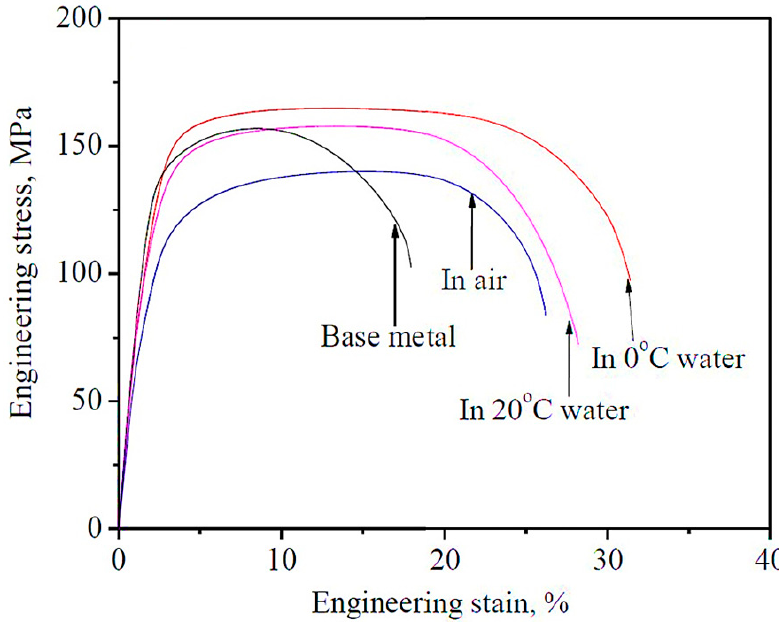
Figure 22. Engineering stress-strain curves of the base metal and weld joints along the longitudinal direction of the hot bands of AA 3003 Al alloy welded in air, 20 °C water, and 0 °C water [59]. Reprinted from: A study on microstructure and mechanical properties of AA 3003 aluminum alloy joints by underwater friction stir welding. Materials Characterization 127 (2017): 41–52, Tan, Y. B., X. M. Wang, M. Ma, J. X. Zhang, W. C. Liu, R. D. Fu, and S. Xiang, Copyright 2017, with permission from